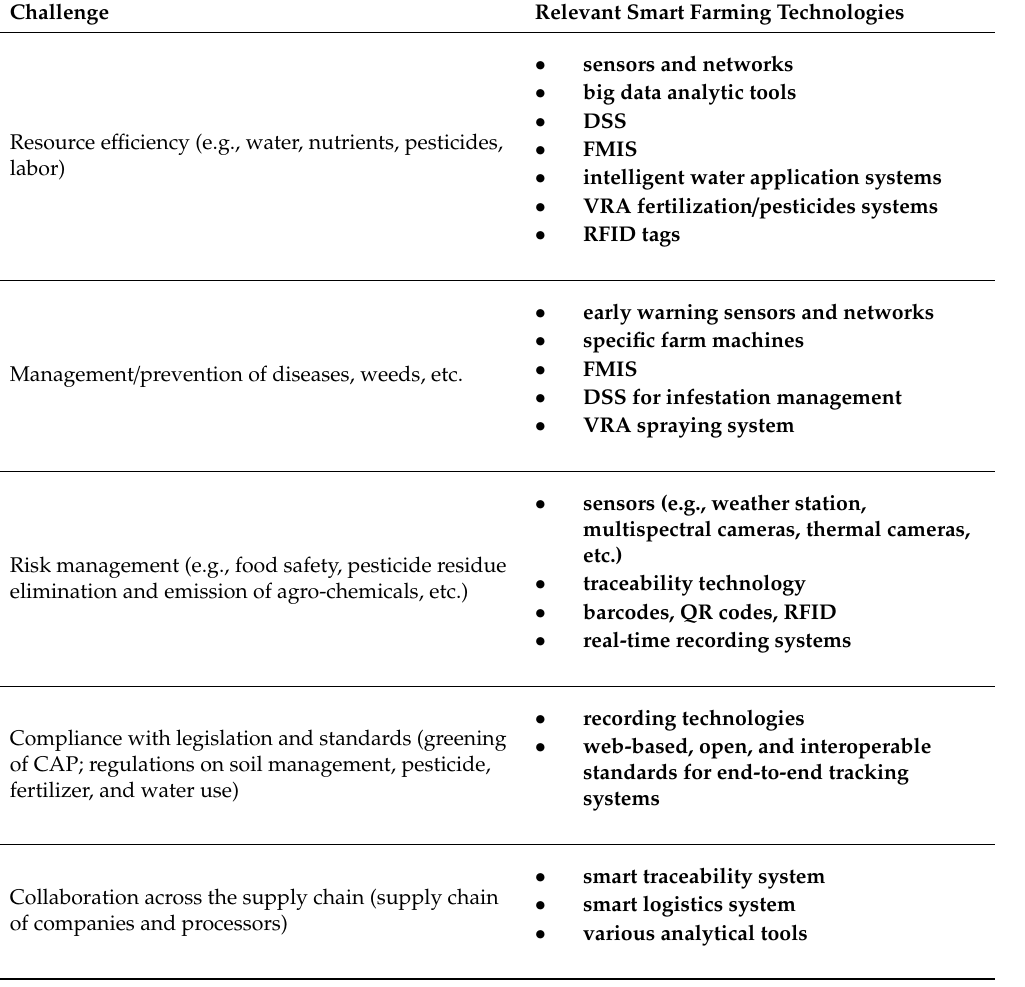
Table 1. Challenges identified in open-field farming accompanied by relevant smart farming technologies (SFTs) that could address them. DSS—decision support system; FMIS—farm management information system; VRA—variable rate application; RFID—radio frequency identification; QR – Quick